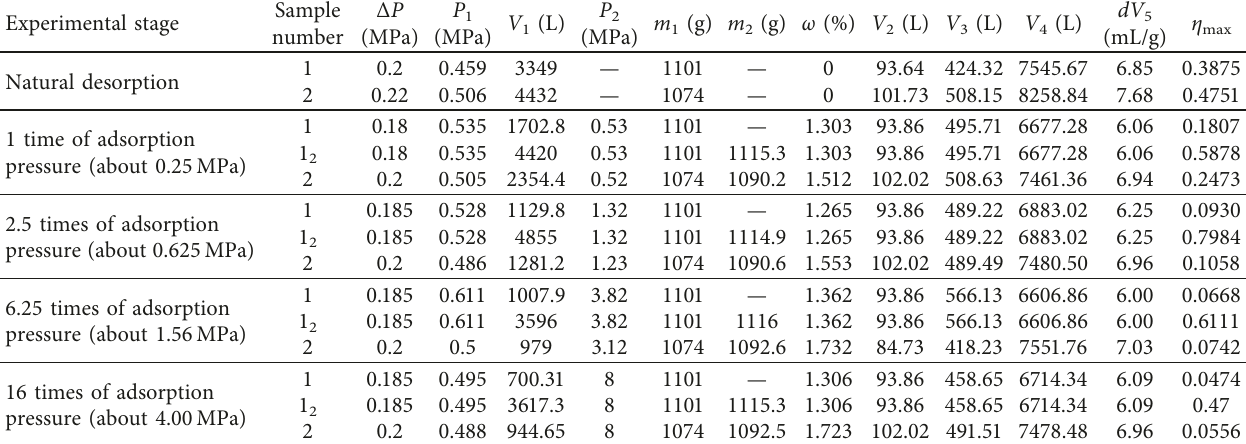
Table 3: Raw data of the two coal samples at gas adsorption pressure around